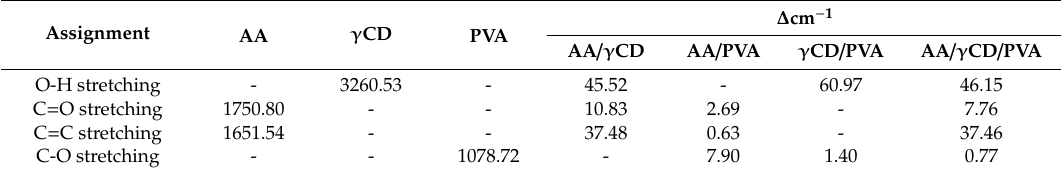
Table 1. Band assignments of ascorbic acid (AA), γ CD, and PVA in binary and ternary